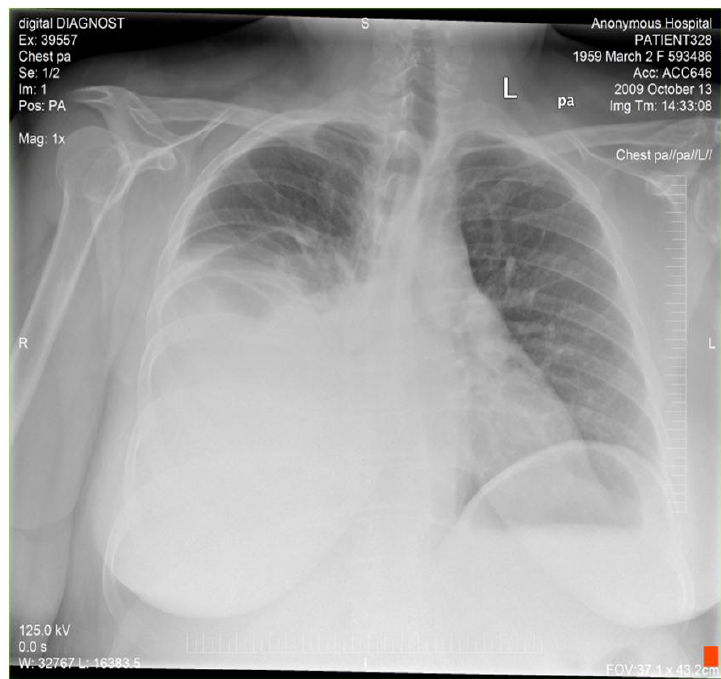
FIGURE 1. Posterior to anterior (PA) CXR showing right-sided pleural effusion.